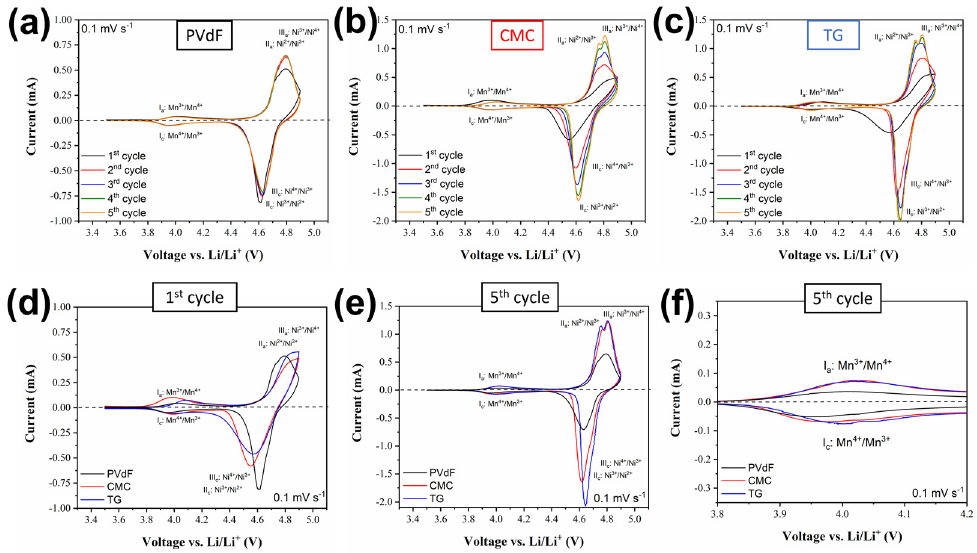
Figure 3. Cyclic voltammetry pro fi les (0.1 mV s − 1 ) of ( a ) LNMO-PVdF; ( b ) LNMO-CMC; ( c ) LNMO- TG; ( d ) fi rst cycle comparison; ( e ) fi fth cycle comparison; ( f ) zoom range of 3.8–4.2 V in the fi fth- cycle pro fi le. ( c ) LNMO-TG; ( d ) first cycle comparison; ( e ) fifth cycle comparison; ( f ) zoom range of 3.8–4.2 V in the fifth-cycle profile.